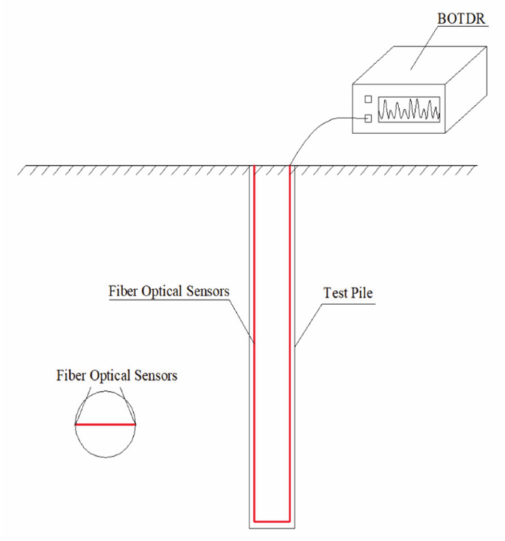
Figure 3. Arrangement